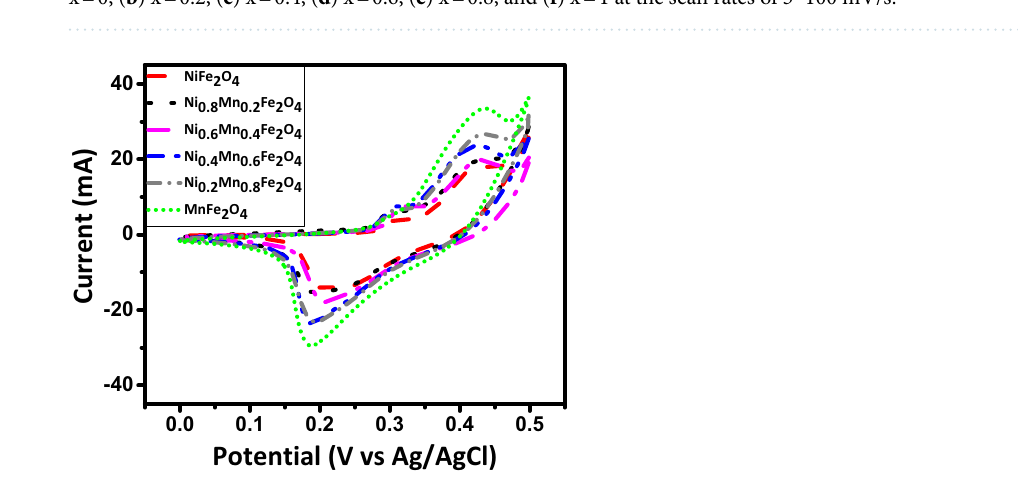
Figure 9. Comparative CV curves of the electrodes constructed from the prepared Ni 1−x Mn x Fe 2 O 4 nanoparticles at the scan rate of 5